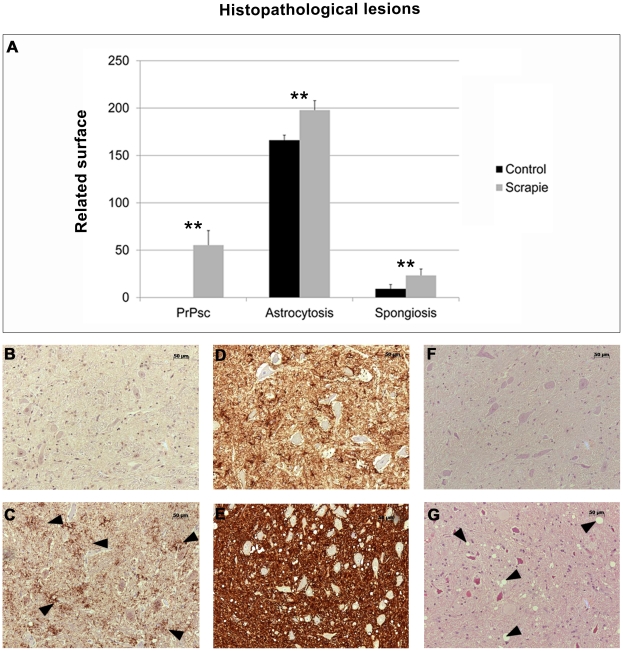
Quantitative values of PrPSc deposition, Glial fibrillary acidic protein expression as a marker for astrocytes and spongiform degeneration is shown as the mean ± standard error (A).Black bars: control sheep; grey bars: scrapie-infected sheep. Significant differences were determined using Student's t test (**P<0.01). PrPsc staining in control (B) and scrapie medulla oblongata sample (C). GFAP staining in control (D) and scrapie medulla oblongata sample (E). Haematoxilin/Eosine staining in control (F) and scrapie medulla oblongata sample (G).